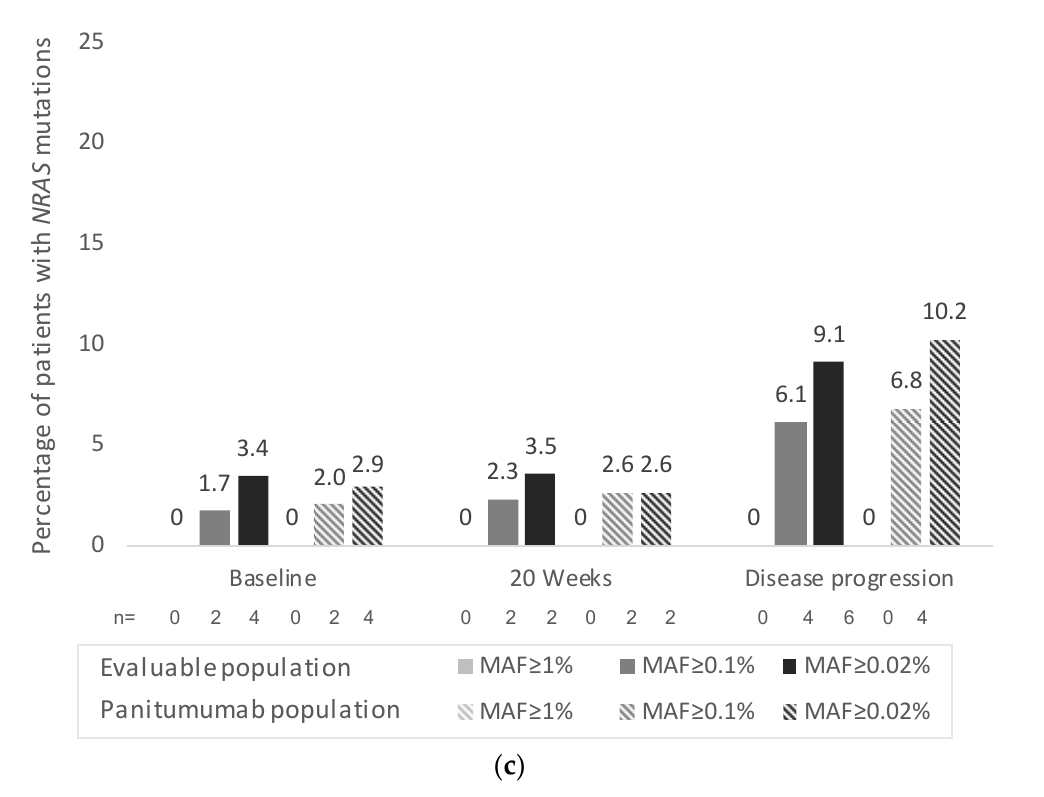
Figure 1. Percentage of patients with ( a ) RAS, ( b ) KRAS, and ( c ) NRAS mutations in liquid biopsies at baseline, at 20 weeks (±2 weeks), and at disease progression according to mutant allele fraction (MAF) cut-offs. One (n = 1) patient had both KRAS and NRAS mutations (MAF ≥ 0.1% and MAF ≥ 0.02%). n: number of patients with mutations. Percentages calculated based on patients with available samples.